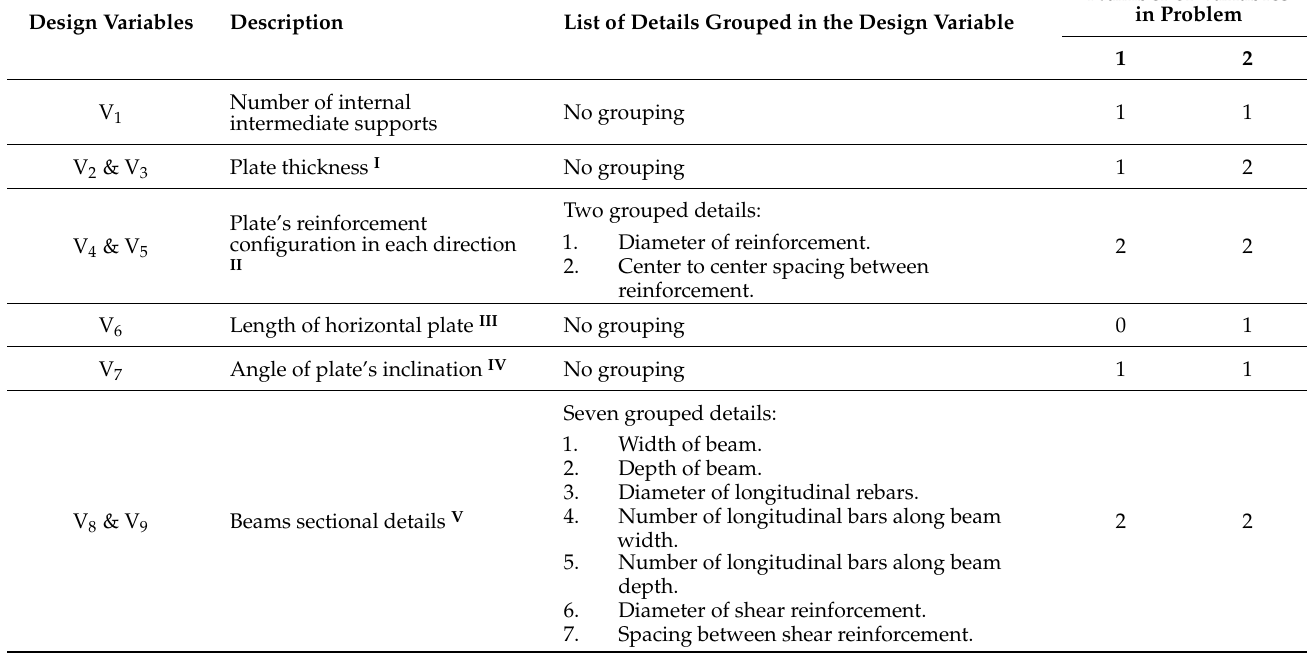
Table 1. Design variable